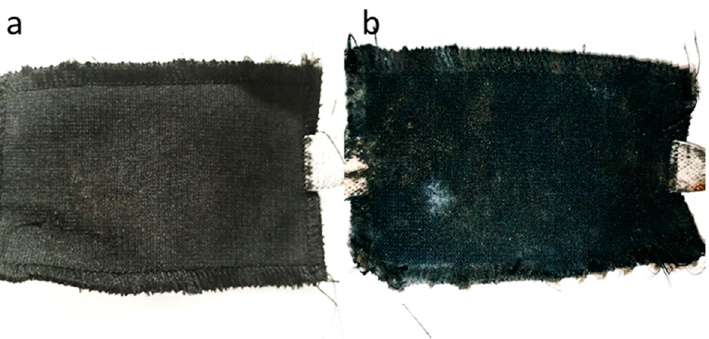
Figure 1. ( a ) Non-exposed armband and ( b ) exposed armband for the assessment of VOC transference on firefighter coats.